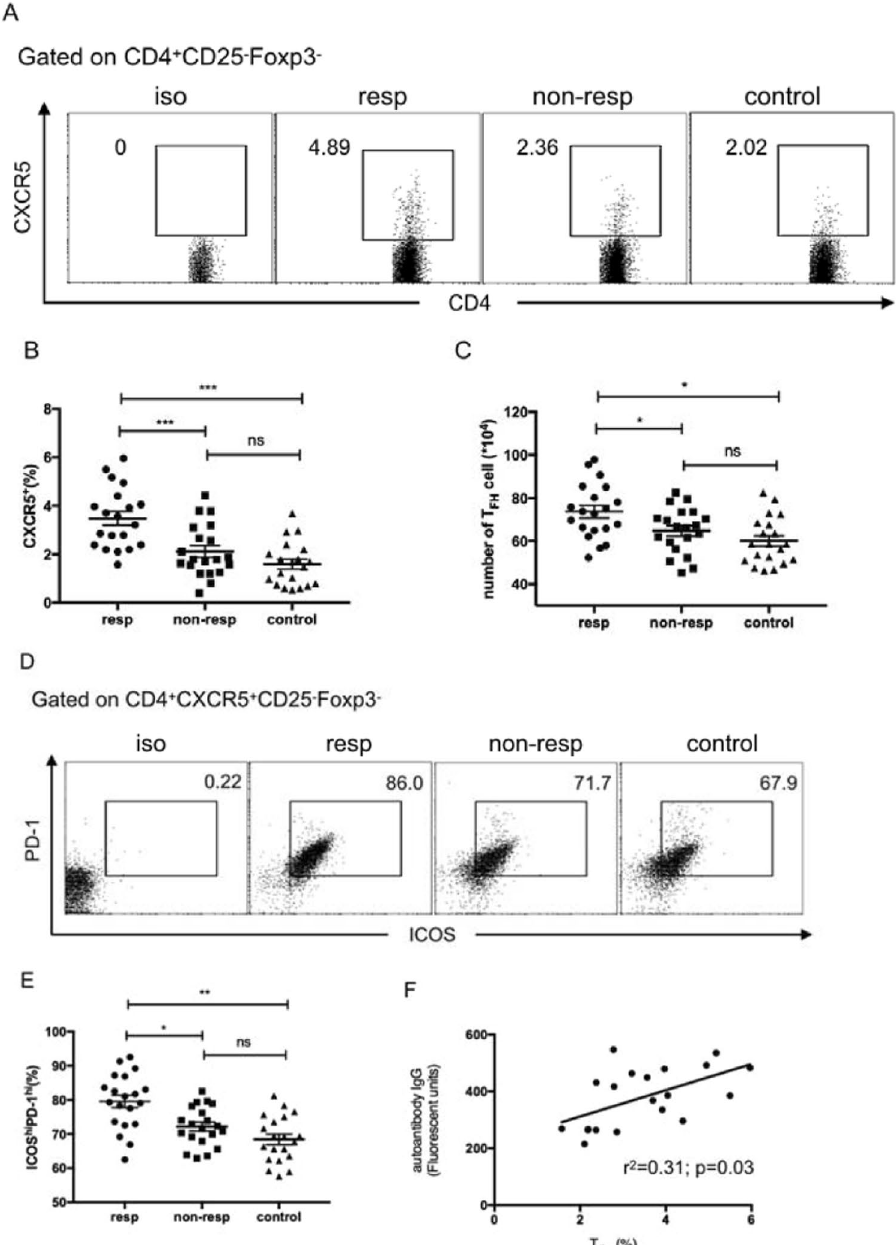
Figure 2. Increased T FH cells in autoantibody-positive AIHA mice. ( A ) The expression of CXCR5 in spleen CD4 + CD25 − FoxP3 − T cells from the responder, non-responder, and control groups. ( B ) The percentages of CXCR5 + cells in CD4 + CD25 − FoxP3 − cells in these three groups. ( C ) The number of CD4 + CXCR5 + CD25 − FoxP3 − T FH cells in spleen in these three groups. ( D ) The expression of ICOS and PD-1 in CD4 + CXCR5 + CD25 − FoxP3 − T FH cells from these three groups. ( E ) The percentages of ICOS hi PD-1 hi cells in spleen CXCR5 + CD4 + CD25 − FoxP3 − T cells in these three groups. ( F ) Relationship of the percentage of CXCR5 + CD4 + CD25 − FoxP3 − T FH cells and the fluorescent units of IgG-specific autoantibodies in the responder group. This experiment was repeated three times with 6-7 mice for each group and each plot represents one mouse in each group. Data shown were the mean ± SEM. * p < 0.05; *** p < 0.001; ns, no